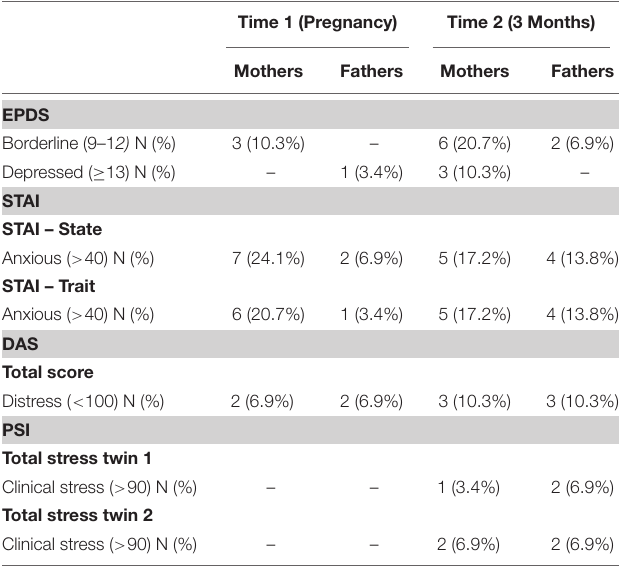
TABLE 1 | Frequency distribution of EPDS, STAI, DAS and PSI for mothers and